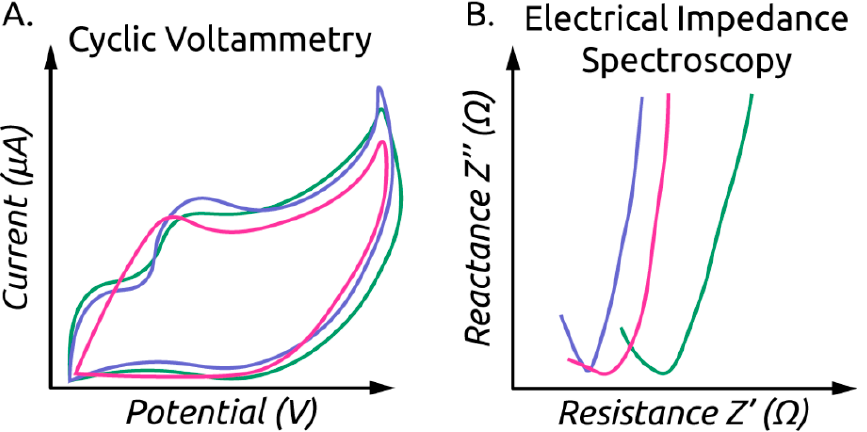
Figure 4. ( A ) Hypothetical cyclic voltammograms for three samples. ( B ) Hypothetical Nyquist plot obtained through EIS showing curves for three samples.